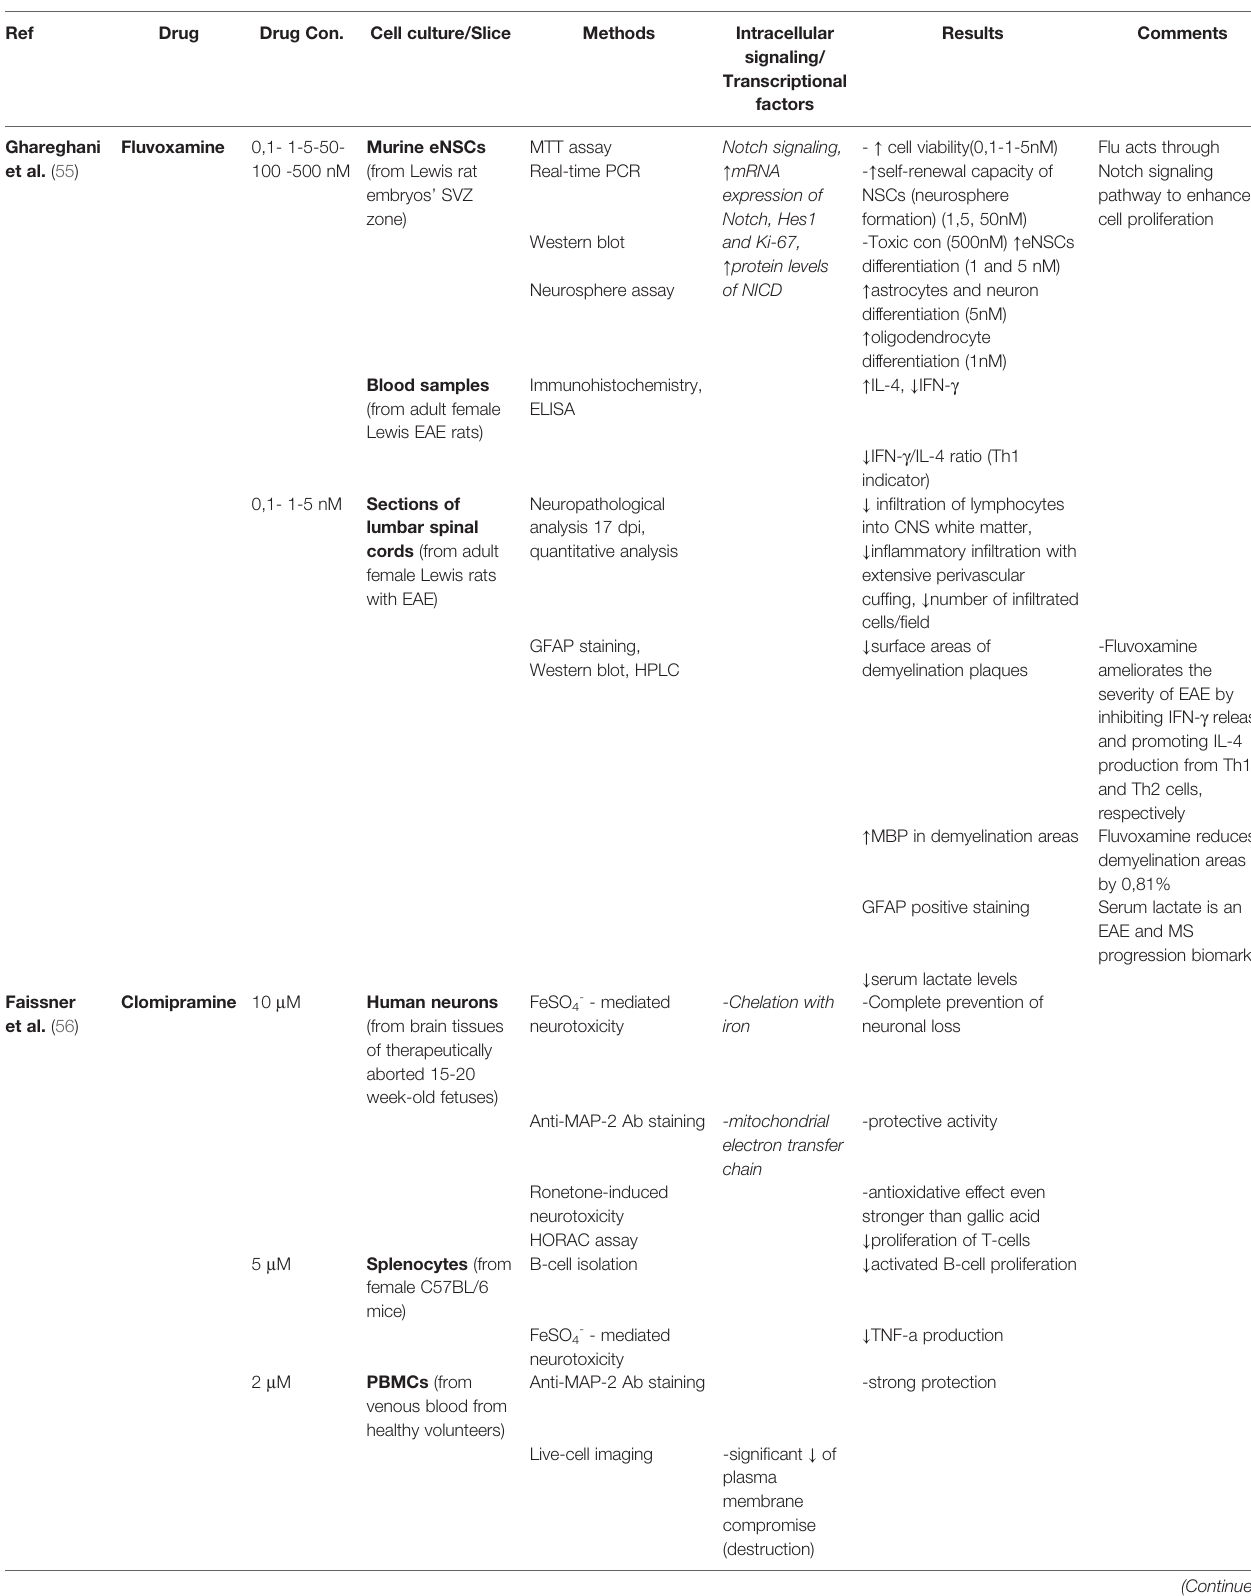
TABLE 1 | Comparative assessment of in vitro studies on the effects of antidepressants in cell and slice